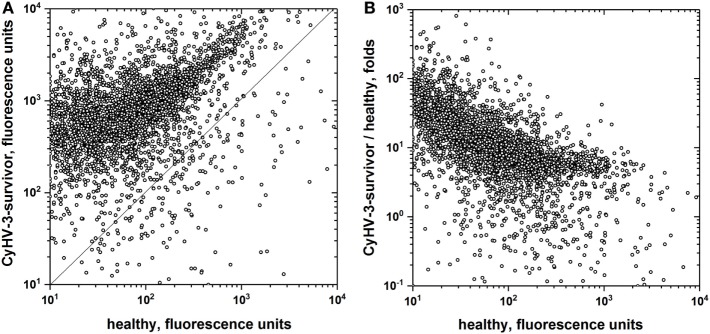
IgM-binding antibodies to a microarray of recombinant human proteins in the sera from cyprinid herpes virus 3 (CyHV-3) infection-survivor and healthy carp. Pooled carp sera from CyHV-3 infection-survivor and healthy carp were screened for IgM binding to a microarray of 20,234 GST-fused recombinant human proteins. Sera were pooled from CyHV-3 infection-survivor (n = 6) and healthy (n = 6) carp, 100-fold diluted and incubated with the microarrays. Bound IgM was detected with biotinylated anti-mouse-IgG and streptavidin-647. Anti-GST staining was used to normalize the resulting fluorescence raw values. Backgrounds resulting from microarrays incubated in the absence of sera were then subtracted. Mean fluorescences were calculated for duplicate spots, values were log2 transformed and statistical significance estimated. (A) IgM binding from CyHV-3 infection-survivor versus healthy carp sera. (B) Folds versus healthy carp sera, folds calculated for each protein by the formula, fluorescence of CyHV-3 infection-survivor carp pooled sera/fluorescence of healthy carp pooled sera. Open circles—IgM binding to each of the microarray proteins. Straight line—same CyHV-3 infection-survivor and healthy fluorescence values.